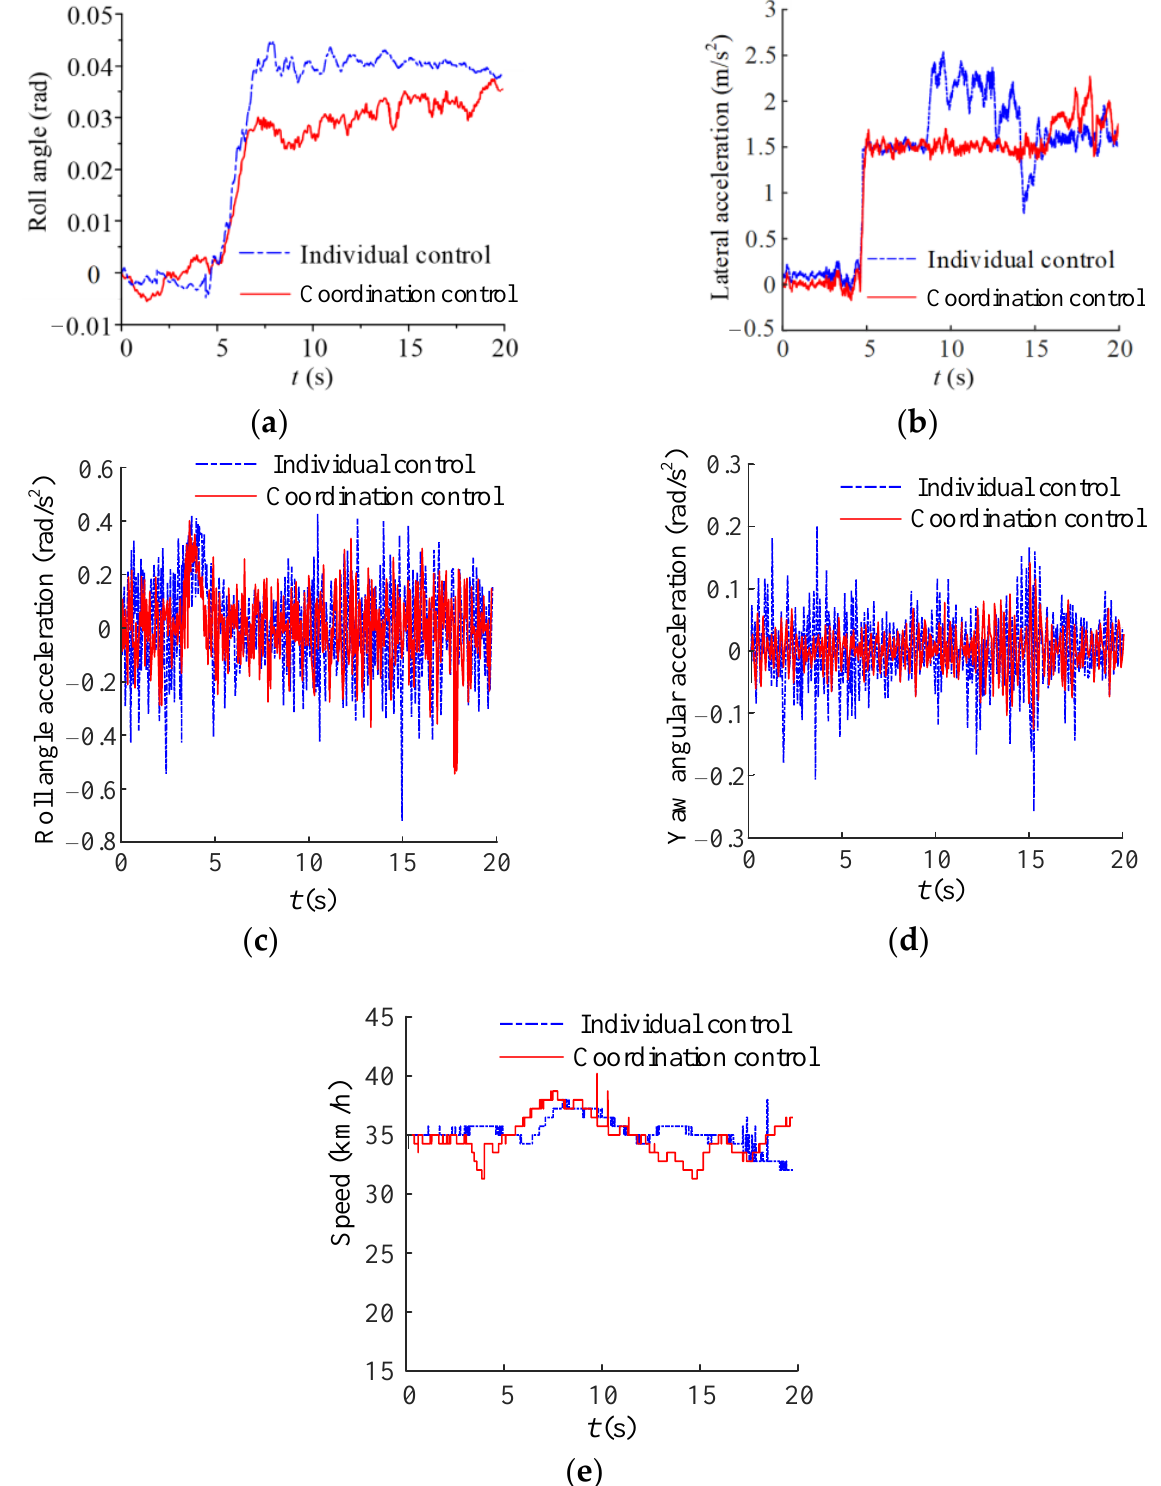
Figure 10. Comparison of test results: ( a ) body roll angle; ( b ) lateral acceleration; ( c ) roll angle acceleration; ( d ) yaw angular acceleration; ( e ) speed. Table 7. RMS value of the performance index.